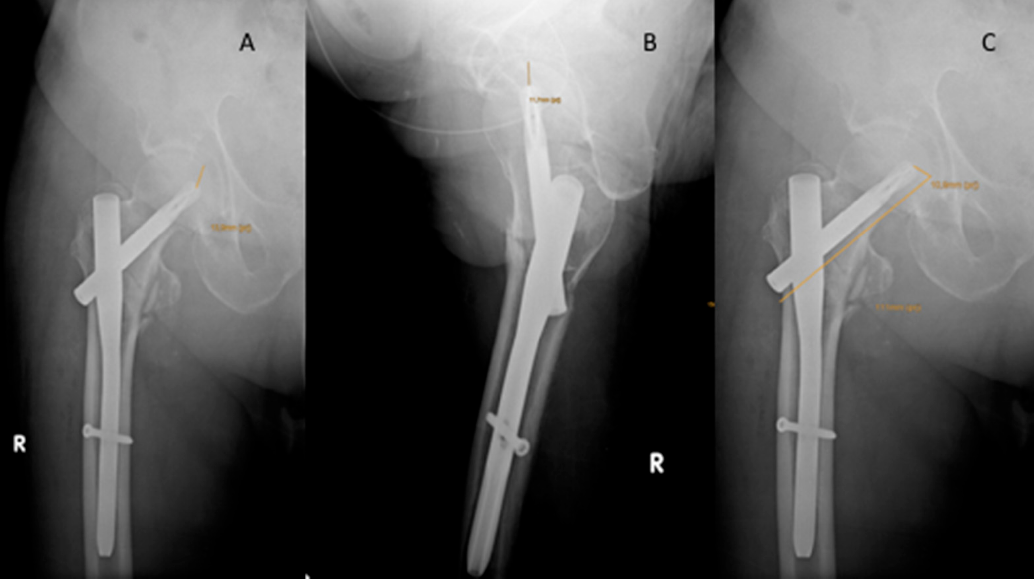
Figure 3. Assessment of the tip–apex distance (TAD) and of the calculated tip–apex distance (calTAD). Assessment of the TAD anterior–posterior view and lateral view (A,B) according to Baumgartner et al. [27], assessment of the calculated calTAD anterior–posterior view ( C ).